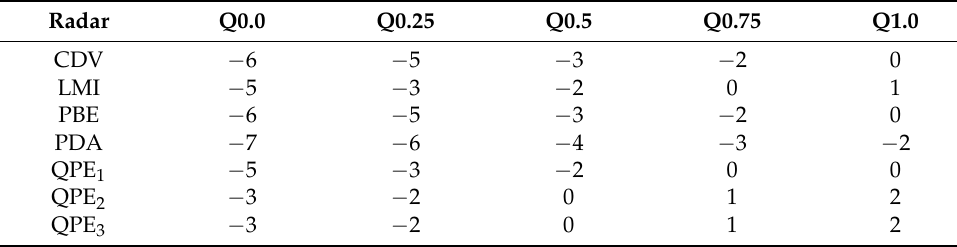
Table 2. Quartile values of bias for the QPE products presented in Figures 3 and